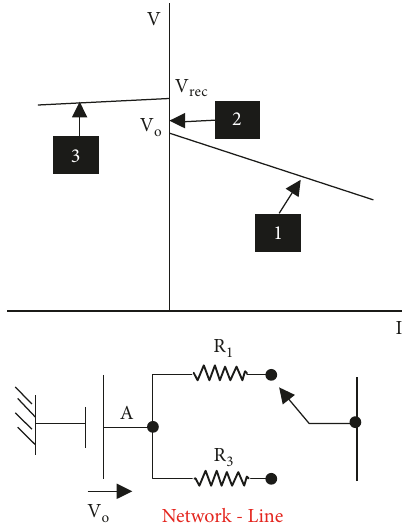
Figure 1: Voltage-current characteristic of an electrical substation